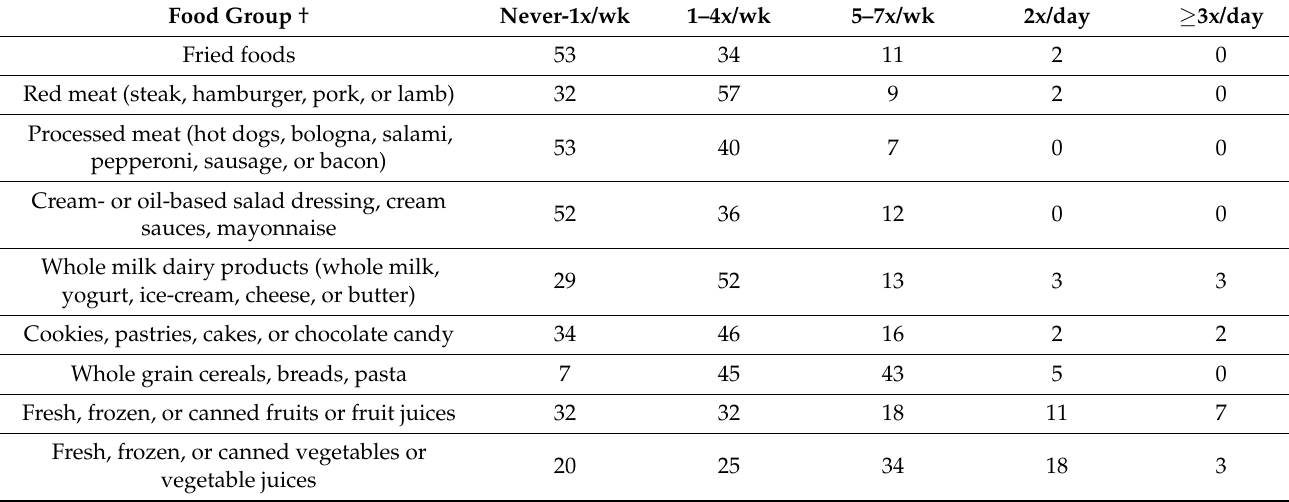
Table 2. Percentage of women who fell in frequency categories from a food frequency screener at baseline in a modified DPP. Food Group